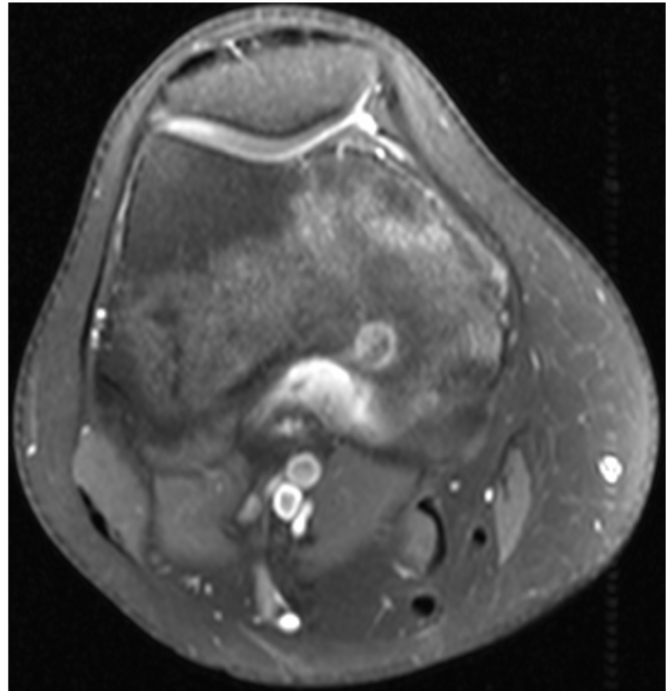
Figure 1. Pre-treatment axial fat-saturated T1, contrast-enhanced MRI of the distal femur. There is an enhancing nidus in the posteromedial distal femoral condyle with surrounding enhancing marrow